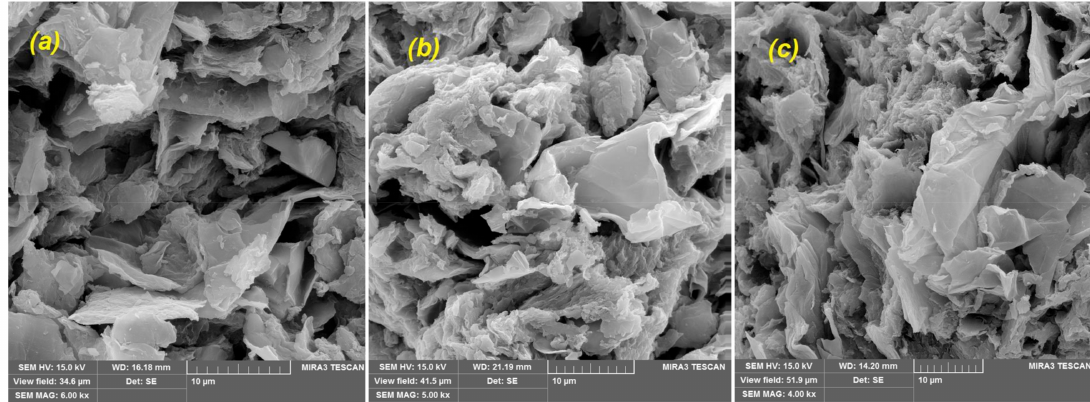
Figure 12. SEM images of CR-adsorbed GO/PAMAM prepared by ( a ) fresh GO/PAMAM and ( b ) and ( c ) two times regenerated GO/PAMAM samples in water under different initial conditions. Samples ( b ) and ( c ) had adsorbed CR molecules in water and at pH of 13 before regeneration cycles,